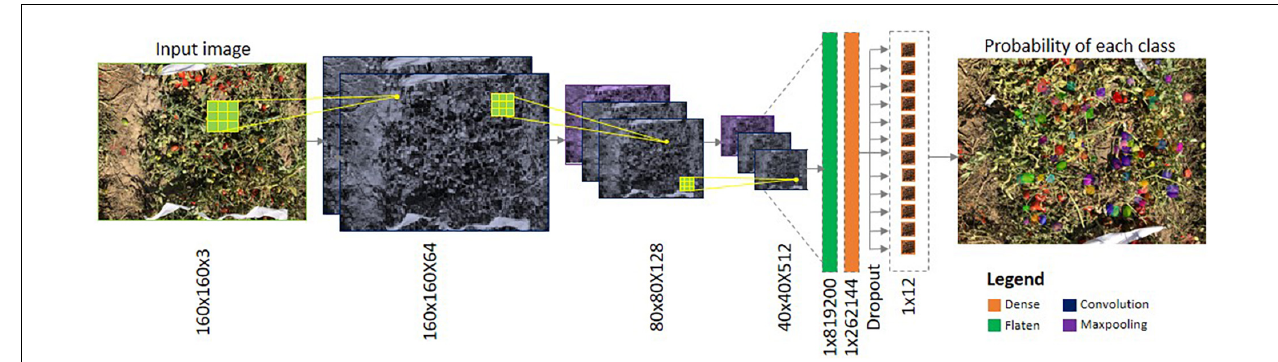
FIGURE 1 | Illustration of a typical Convolutional Neural Network